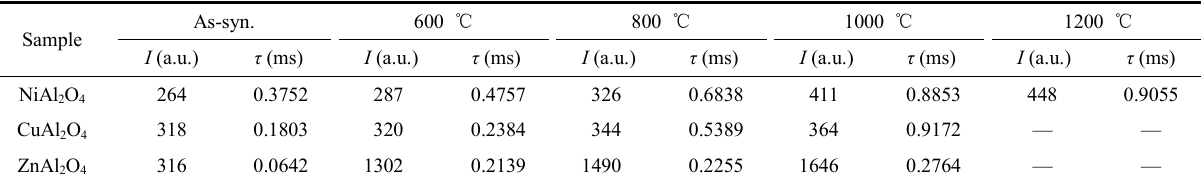
Table 2 Photoluminescence intensity ( I ) and fluorescence lifetime ( τ ) of (a) NiAl 2 O 4 , (b) CuAl 2 O 4 , and (c) ZnAl 2 O 4 powders calcined at different temperatures Sample